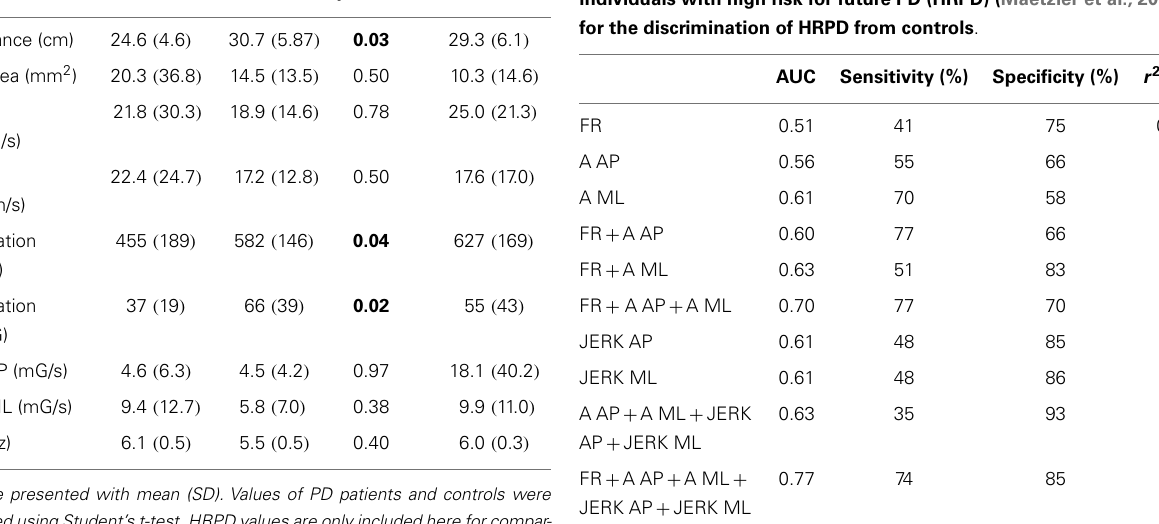
eral direction; FR, functional